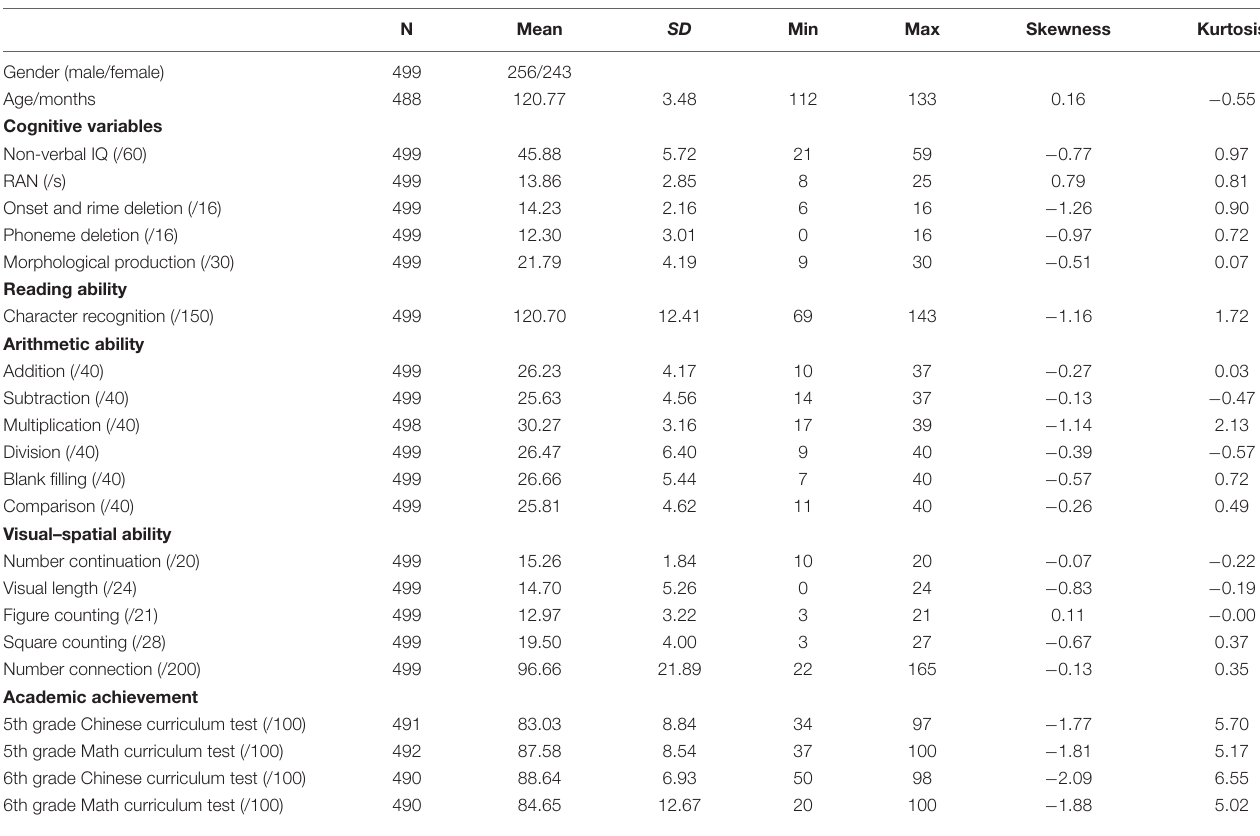
TABLE 1 | Descriptive statistic of all